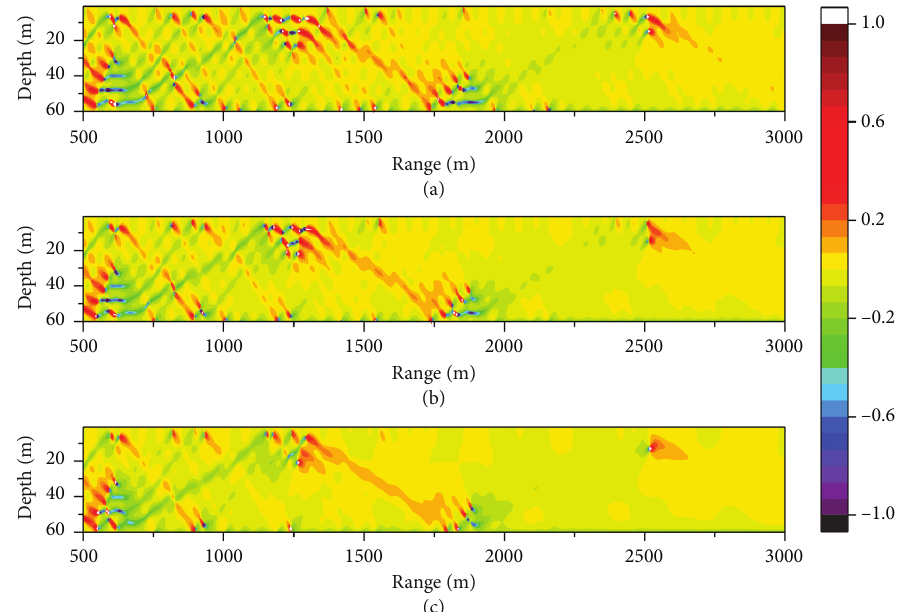
Figure 21: I ∗ (b) α p � α s � 0 . 5dB/ λ ; (c) α p � α s � 1dB/ λ